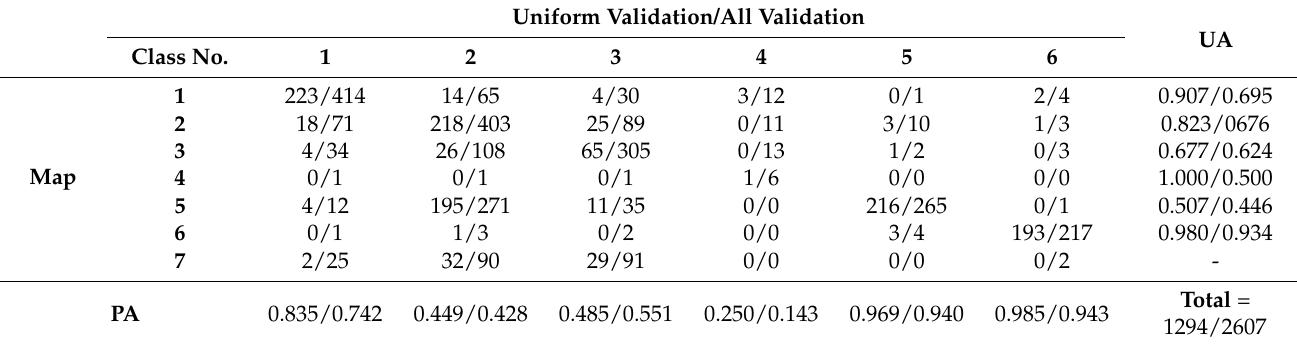
Table 10. Confusion matrix for GlobCover in 990 m